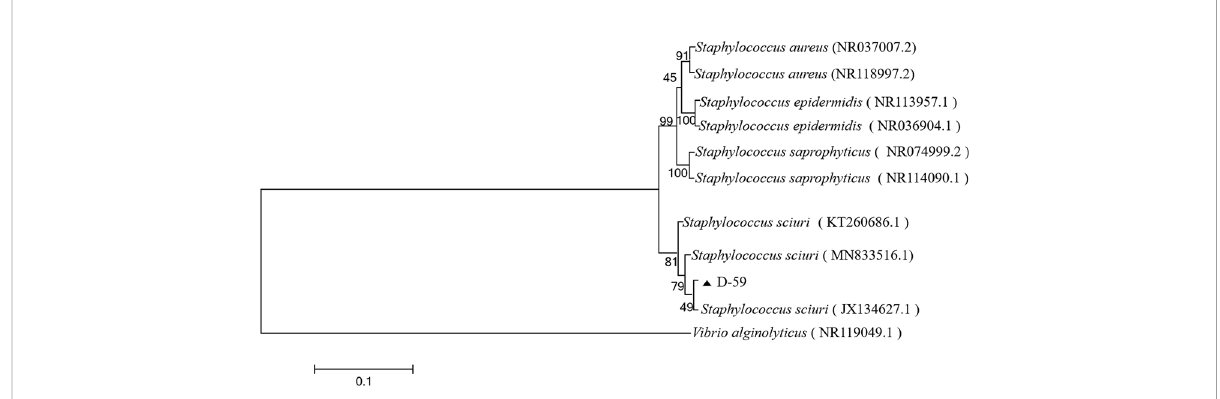
FIGURE 3 Phylogenetic tree of strain D-59. The phylogenetic relationships of the D-59 genotype identi fi ed in this study with the 16S rRNA nucleotide sequences of other reported genotypes. The MEGA 7.0 program was used to construct the phylogenetic tree using multiple sequences matching the sequences of nine members of the genus Staphylococcus and the Neighbor-joining method. The number at each branch indicates the percentage of bootstrap values for 1000 replicates. The scale bar indicates the number of substitutions per